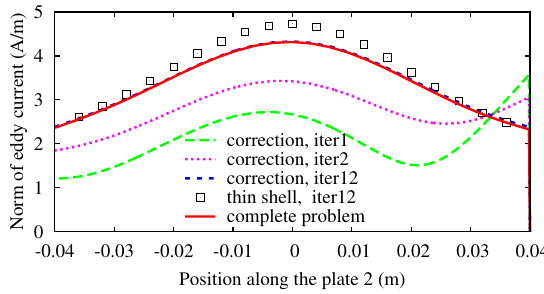
Fig. 5. The eddy current ∥ j ∥ (A/m) along the thin plate2 for different iterations.